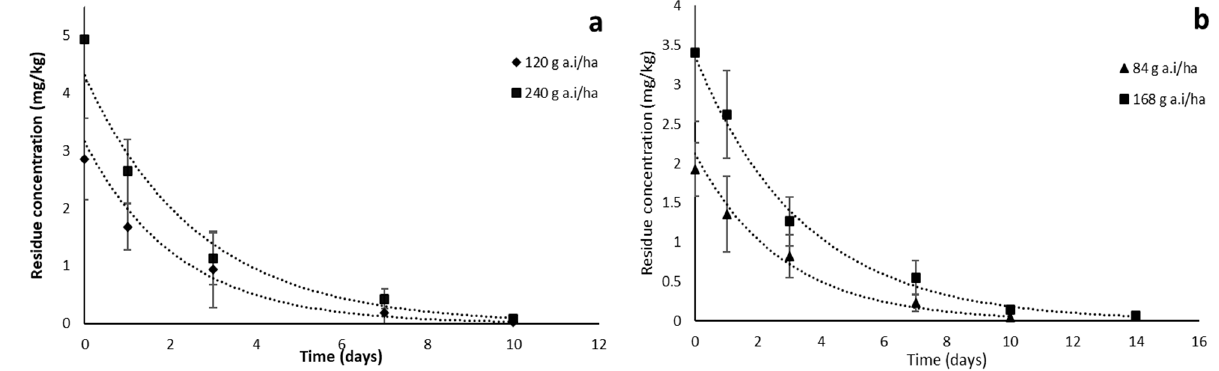
Figure 4. Dissipation of spiromesifen ( a ) and spirodiclofen ( b ) in tomato fruits.